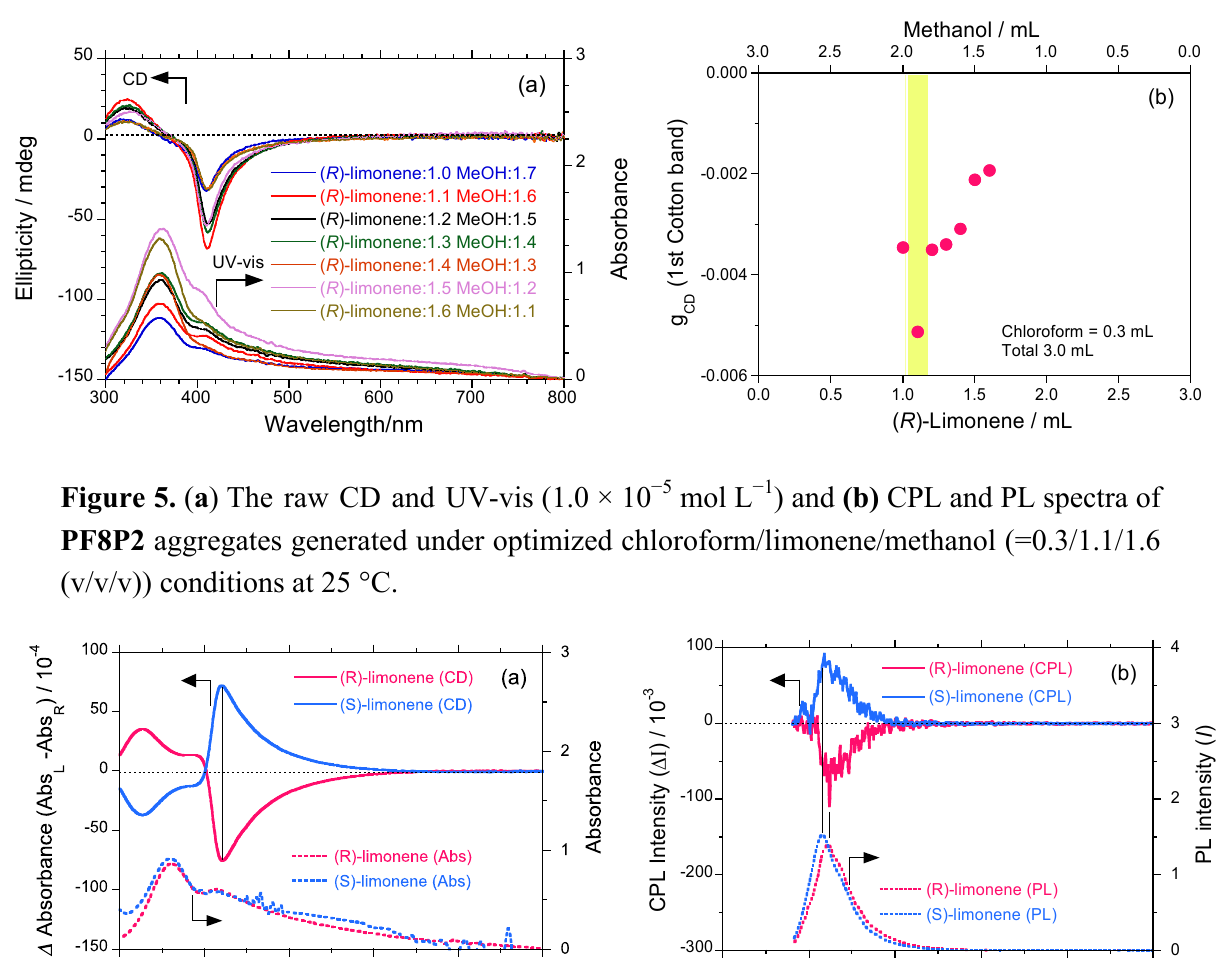
Figure 4. ( a ) Changes in the CD and UV-vis absorption spectra of PF8P2 aggregates in chloroform (0.3 mL fixed) simultaneously varying the volume fractions of ( R )-limonene and methanol. ( b ) The g value at ~405 nm as a function of volume fractions of ( R )-limonene CD